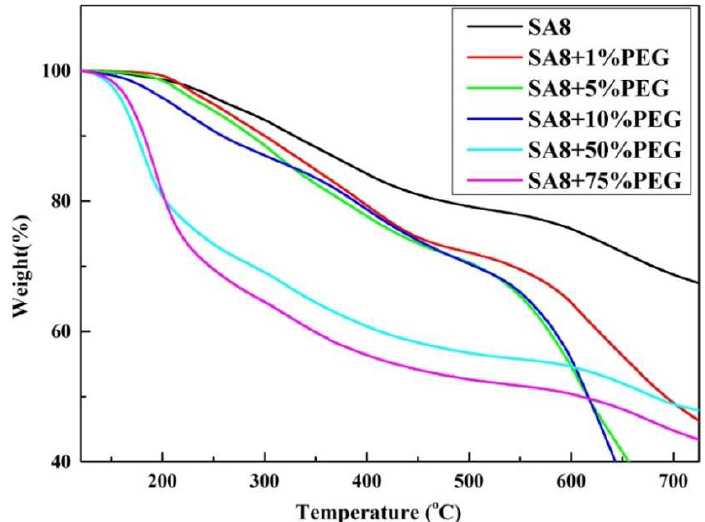
Figure 11. Thermogravimetric analysis (TGA) diagram of SA8 polymer blended with PEG.